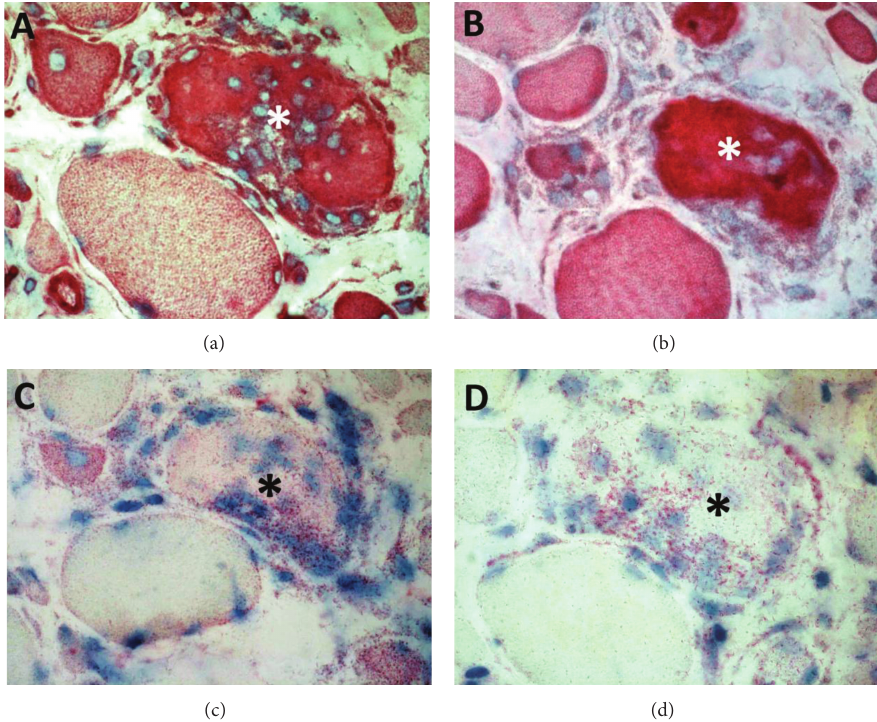
Figure 2: Chemokine staining in Duchenne muscular dystrophy. Nonconsecutive sections showing the same microscopic field containing a necrotic muscle fiber invaded by macrophages (asterisk). The muscle biopsy was taken from an 8-year-old patient with Duchenne muscular dystrophy caused by duplication of dystrophin exon 2. Upon diagnostic myopathological evaluation, the biopsy displayed severe muscle damage, few groups of revertant fibers, and strong utrophin staining. Chemokines were immunostained and visualized with a secondary antibody using the streptavidin-biotin labeling system and 3-amino-9-ethylcarbazole chromogen (Dako, Glostrup, Denmark). Cell nuclei were counterstained with hematoxylin (blue). The sarcoplasm of a necrotic fiber is strongly positive for CXCL8 (red in (a)) and CXCL11 (red in (b)). The cytoplasm of the necrotic fiber and its invading inflammatory cells are moderately positive for CCL5 (red in (c)) and faintly positive for CCL17 (red in (d)). Small regenerating fibers stain for all four chemokines with varying